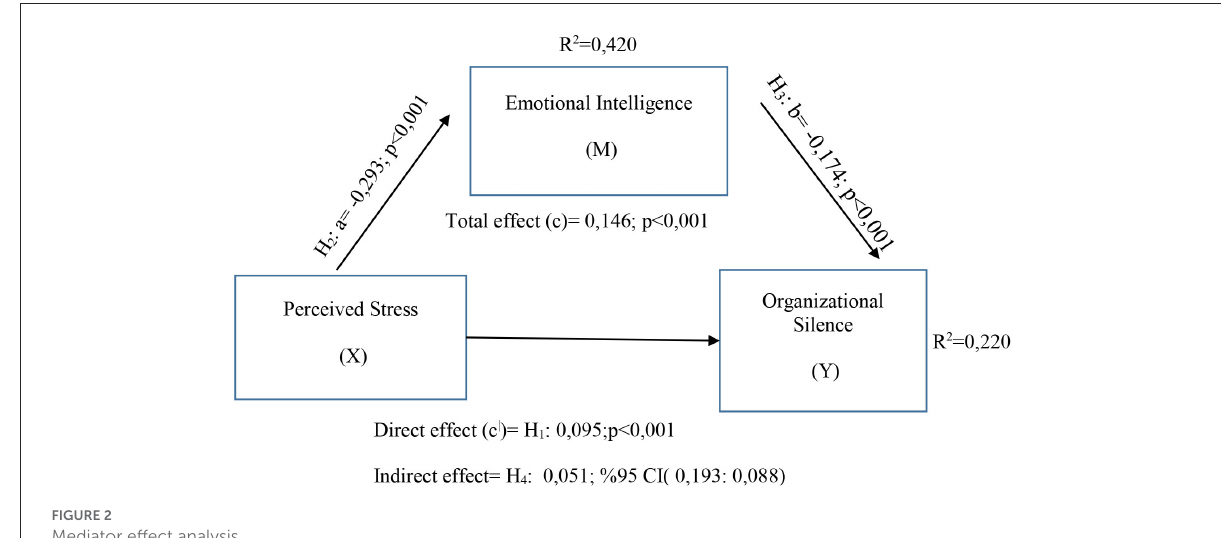
FIGURE2 Mediator effect